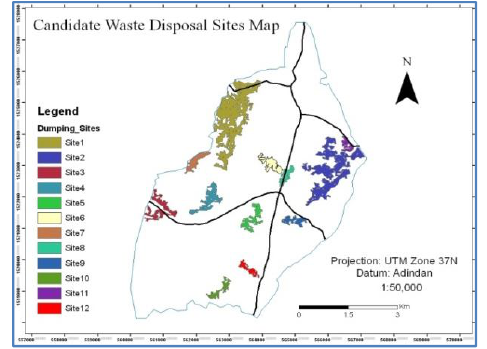
Figure 3: Candidate Waste disposal Sites